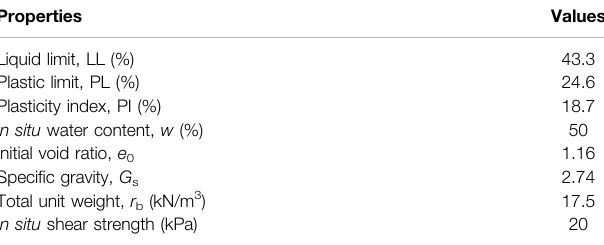
TABLE 1 | Basic properties of the soil used in the current study. Properties